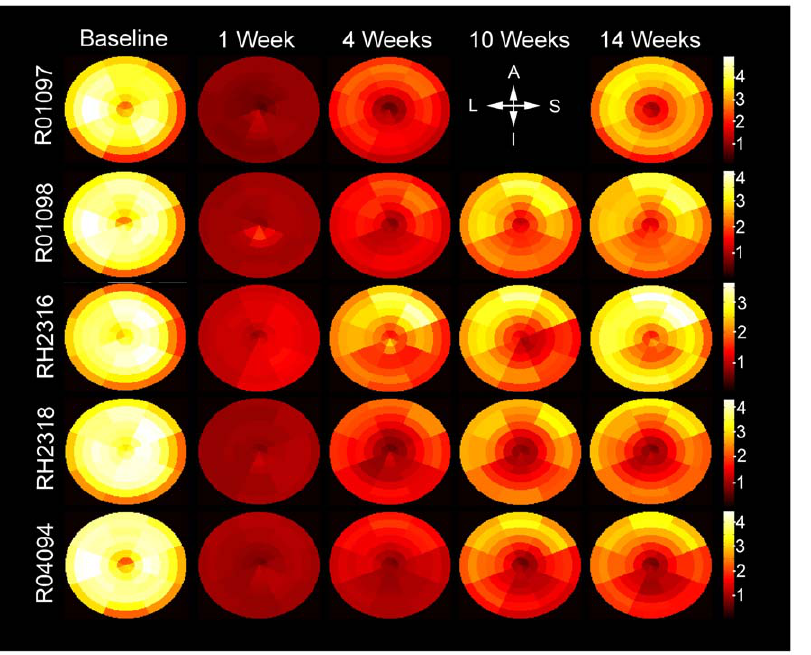
Figure 3. Distribution volume maps before and after systemic 6-OHDA dosing. Maps express regional capacity of the tissue for MHED uptake relative to whole blood, thus providing a measure of the density of nerve terminals. Each individual map consists of 8 sectors and 7 rings (apex of the heart at the center, base of the LV at the edge), totaling to 56 blocks of data per timepoint. MHED uptake significantly decreased at each timepoint after 6-OHDA compared to baseline ( P , 0.001). Scales (mL whole blood/g tissue) are similar between animals and identical across time points for each individual. The compass rose indicates regions: A, anterior; S, septal; I, inferior; L, lateral.